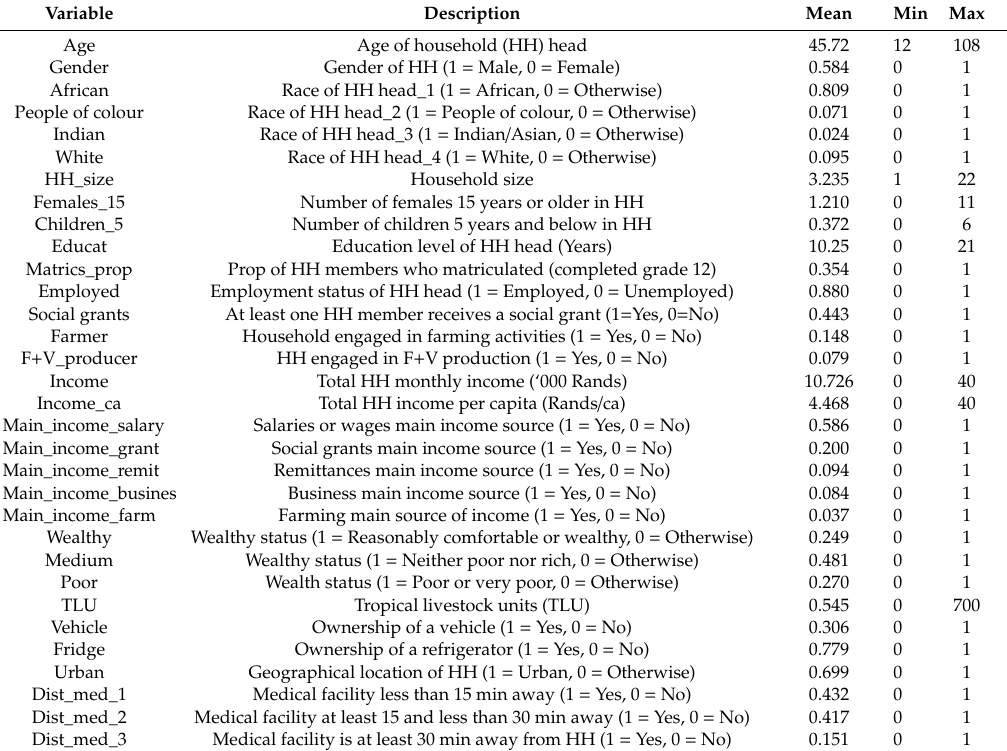
Table 3. Sample demographics and socio-economic